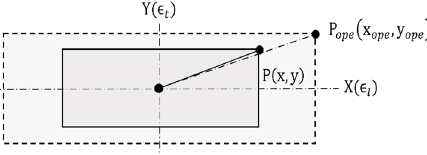
Figure 1. Dynamical stretching geometry of the uniaxial flexible NPR microstructure mold.